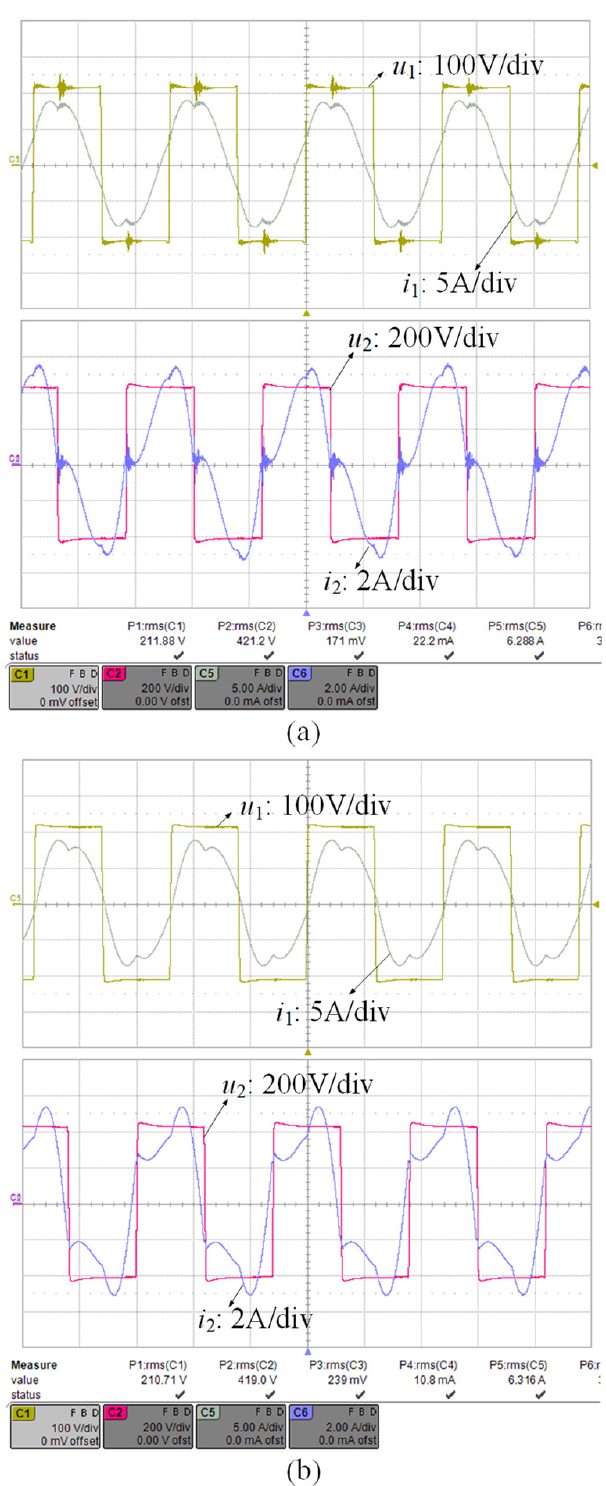
Figure 9. Experimental waveforms with 2.0 voltage gain: ( a ) synchronous rectification; ( b ) 90° phase shift.